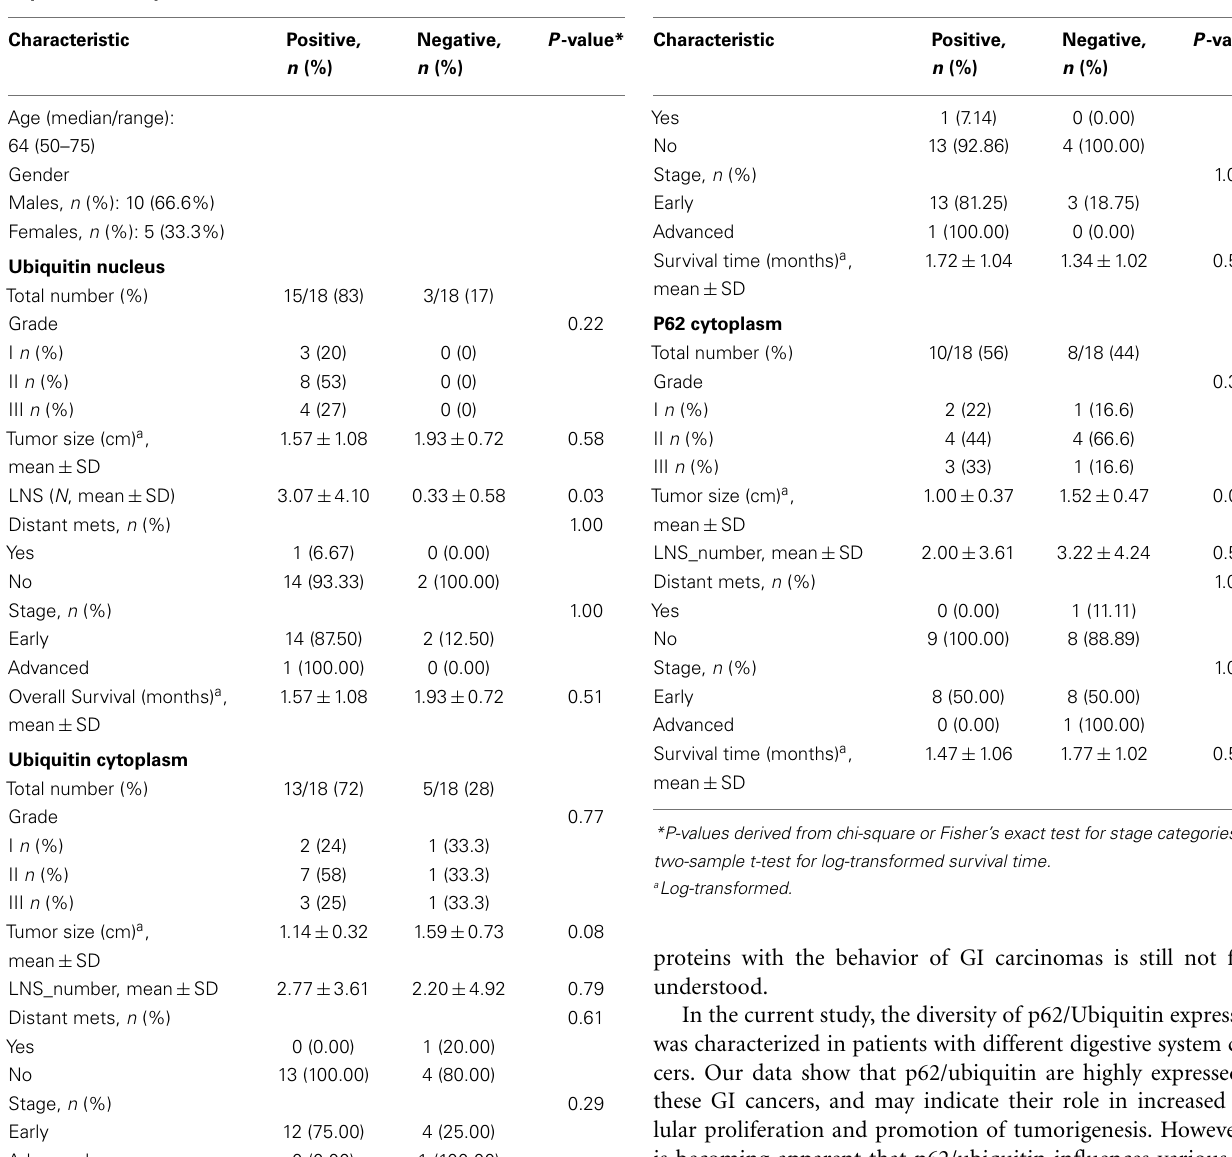
Table 3 | Multivariate analysis of tumor variables and overall survival in patients with pancreatic adenocarcinoma ( n = 18)